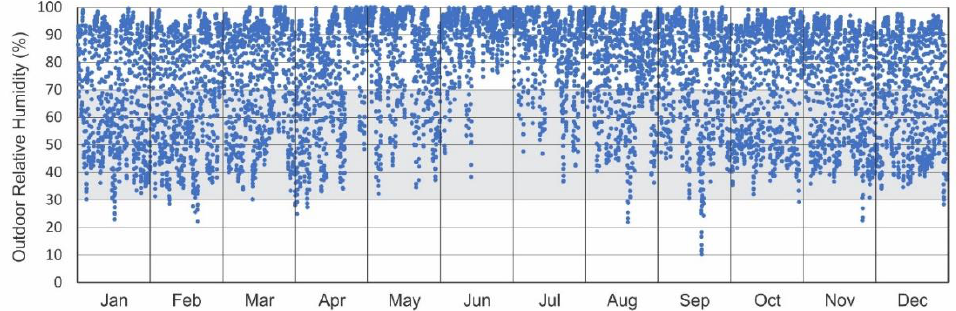
Figure 4. Outdoor relative humidity in study location during 2020.